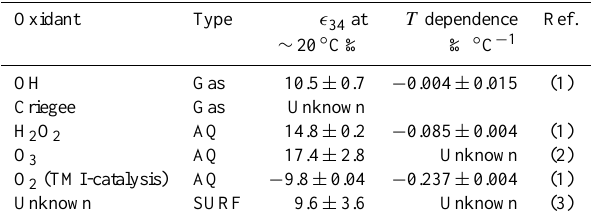
Table 2. Sulfur isotope fractionation factors for the major known continental atmospheric SO 2 oxidation pathways. (cid:15) 34 = (α 34 − 1 ) × 1000; i.e. (cid:15) 34 is an expression of α 34 in ‰. Reaction types: Gas = gas phase, AQ = aqueous, SURF = surface oxidation on min- eral dusts, possibly with O 3 as an oxidant, as described in Harris et al. (2012a). References: (1) Harris et al. (2014), (2) Harris et al. (2012b), (3) Harris et al.